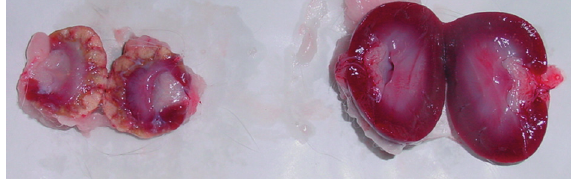
Figure 2 - Macroscopic photographs of the right (embolized) kidney and the contralateral (control) kidney immediately after sacrificing the animal (these kidneys are from an animal in the 90-day post-embolization PVAc